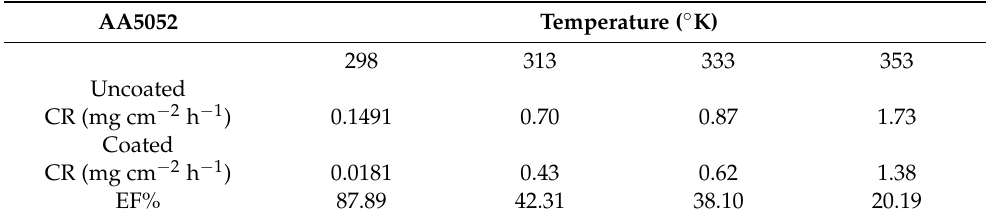
Table 2. Effect of temperature on corrosion rate and inhibitor efficiency on 20 min EPD time technique in 0.5 M H 2 SO 4